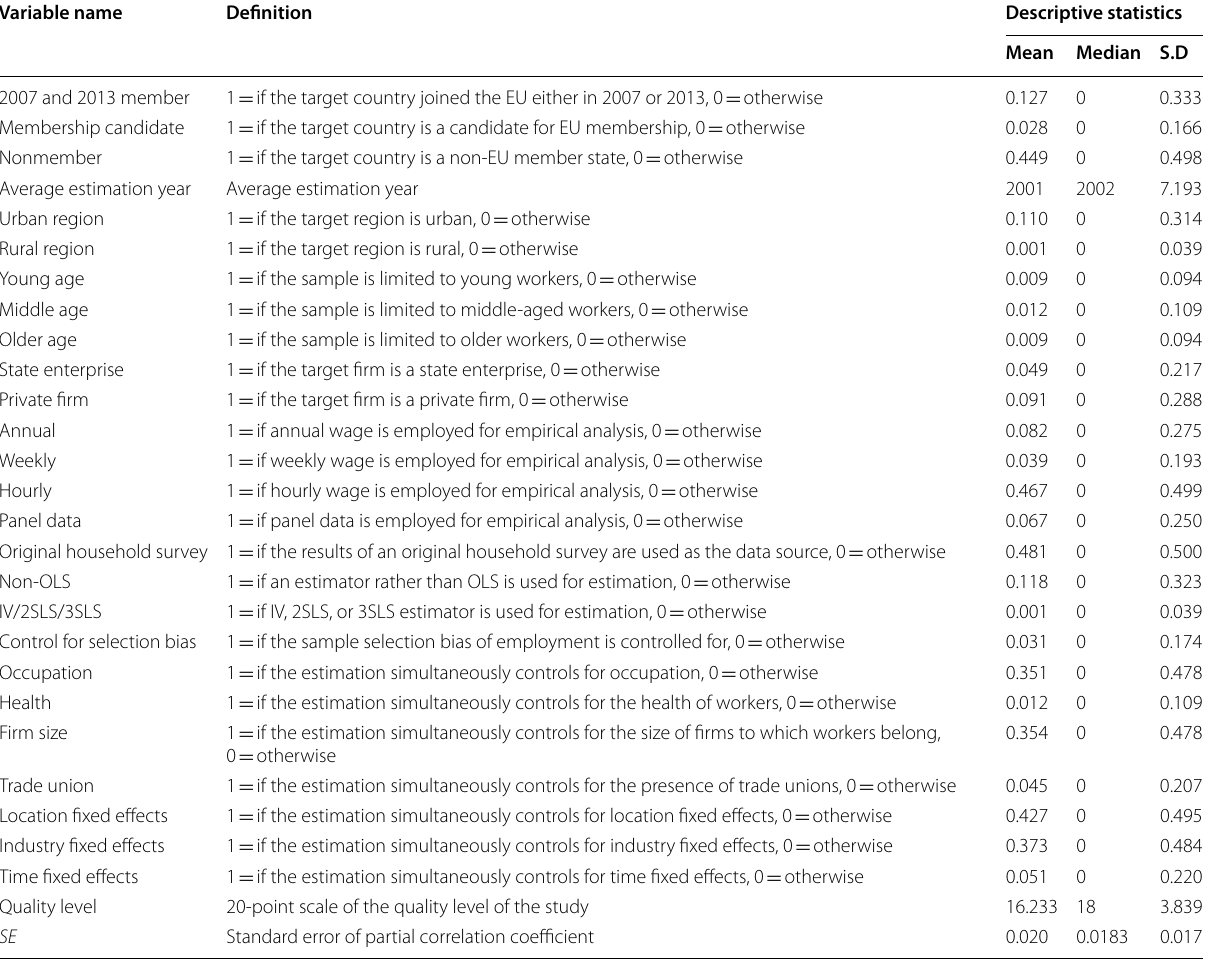
Table 3 Name, definition, and descriptive statistics of meta-independent